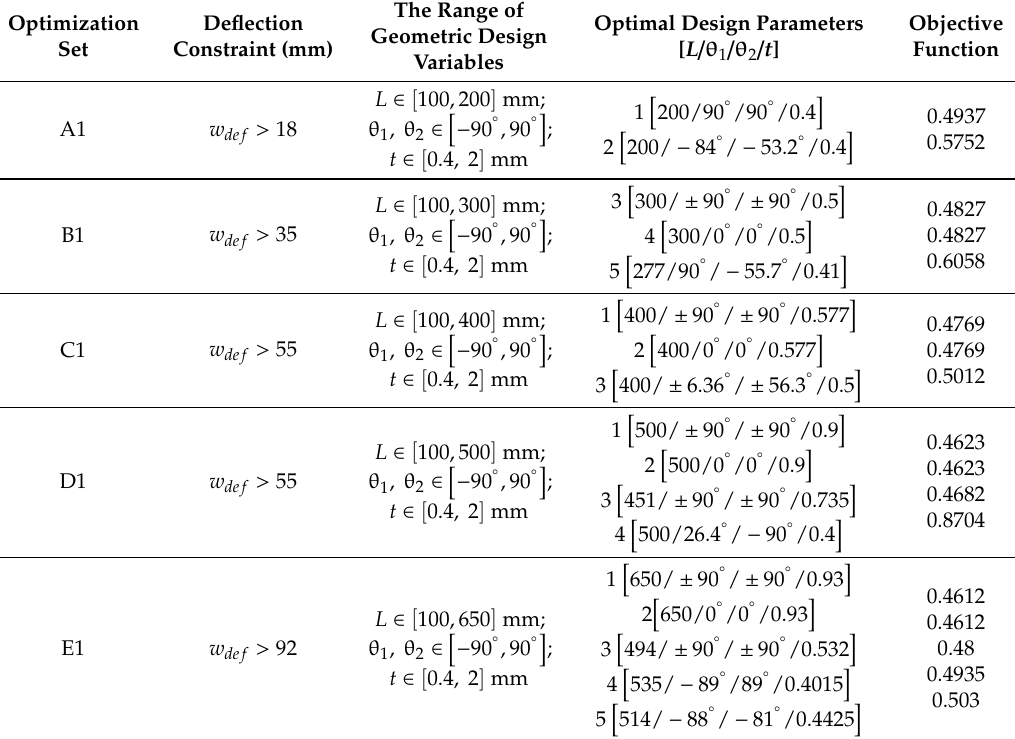
Table 4. Optimal design parameters for deflection constrained optimization with ϕ 1 = 45 ◦ , ϕ 2 = 0 ◦ . Optimization